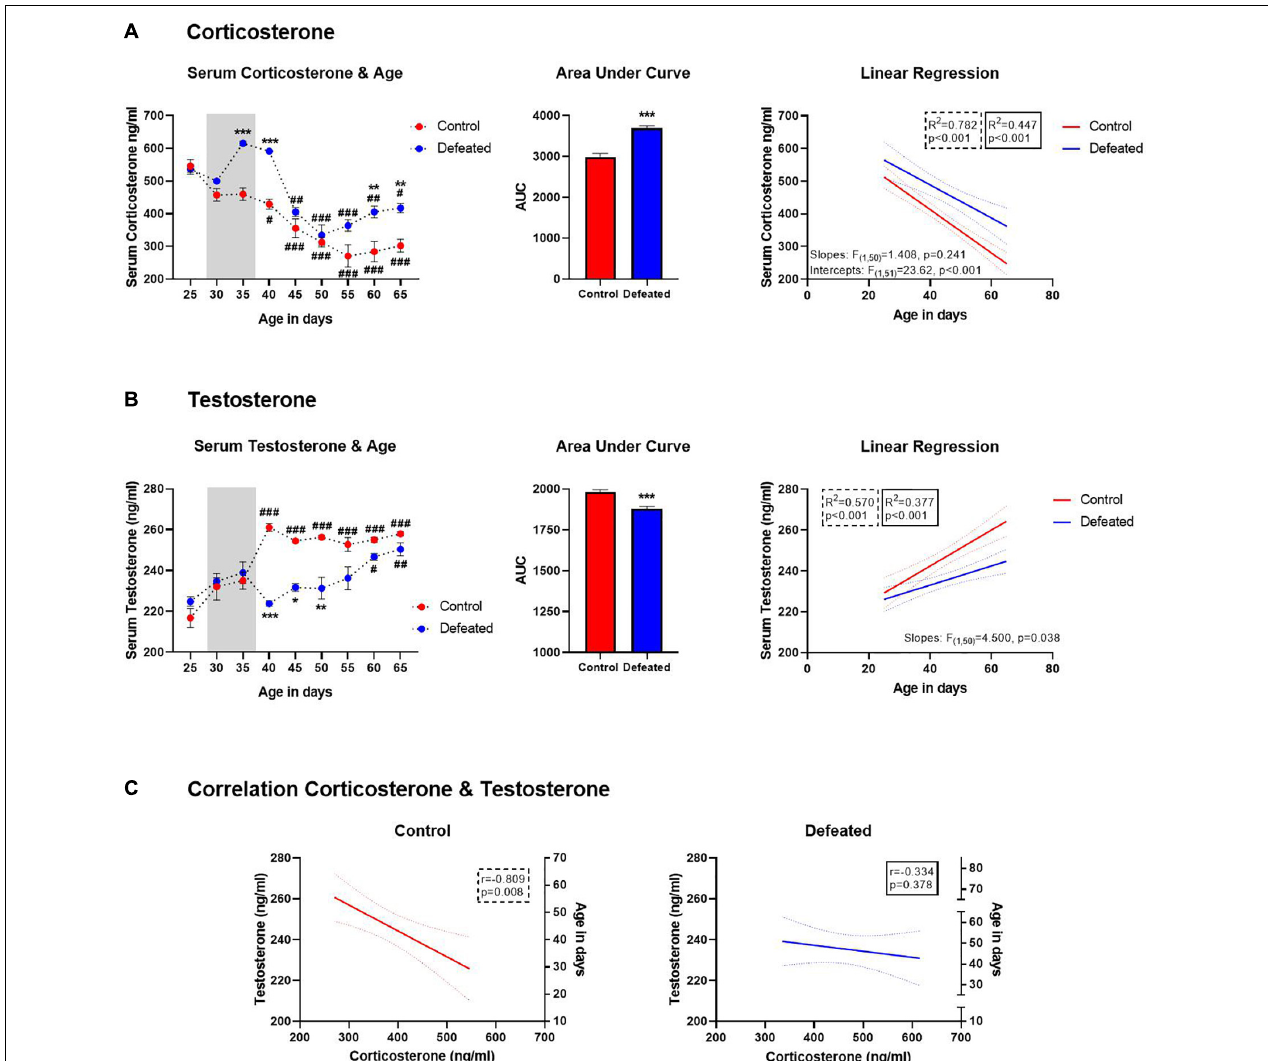
FIGURE 4 | (A) Serum corticosterone content (ng/ml) before, during, and after of the CSD (gray bar), data are presented as the mean ± SEM of the serum corticosterone content, two-way ANOVA post hoc Tukey’s test, ** p < 0.01, *** p < 0.01 vs. control, # p < 0.05, ## p < 0.01, ### p < 0.001 vs. day 25 in both groups (left side). Area under the curve for serum corticosterone before, during, and after of the CSD (central side). Serum corticosterone was linearly correlated with the age of mice in both control and defeated group (right side). (B) Serum testosterone content (ng/ml) before, during, and after of the CSD (gray bar), data are presented as the mean ± SEM of the serum testosterone content, Two-way ANOVA post hoc Tukey’s test, * p < 0.05, ** p < 0.01 *** p < 0.01 vs. control, # p < 0.05, ## p < 0.01, ### p < 0.001 vs. day 25 in both groups. Area under the curve for serum testosterone before, during, and after of the CSD (central side). Serum testosterone was linearly correlated with the age of mice in both control and defeated group (right side). (C) Left side, in control mice the serum testosterone was linearly correlated with the serum corticosterone; right side, in defeated mice there was no correlation between serum testosterone and corticosterone.